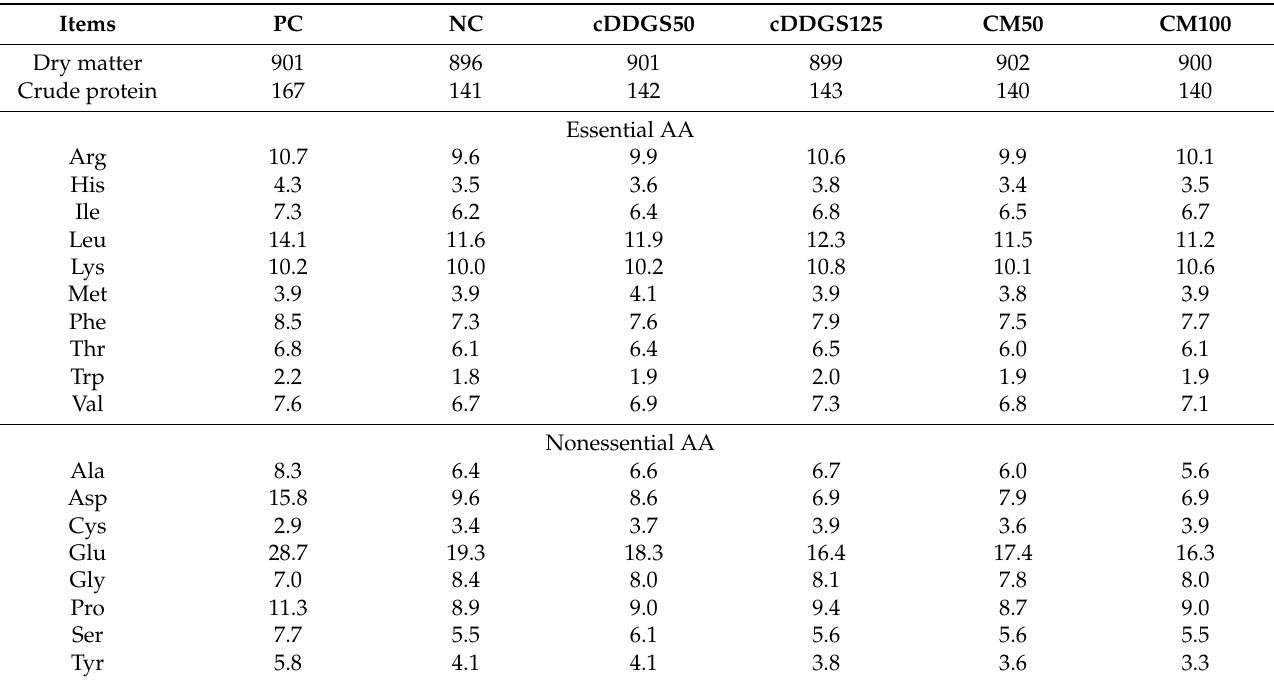
Table 6. Analyzed crude protein and total amino acids content (g/kg, as fed) of finisher diets (d 28 to 42) fed to broilers receiving diets containing soybean with reduction in crude protein or low-protein diets with serial inclusion levels of canola meal or corn–DDGS supplemented with crystalline amino acids.